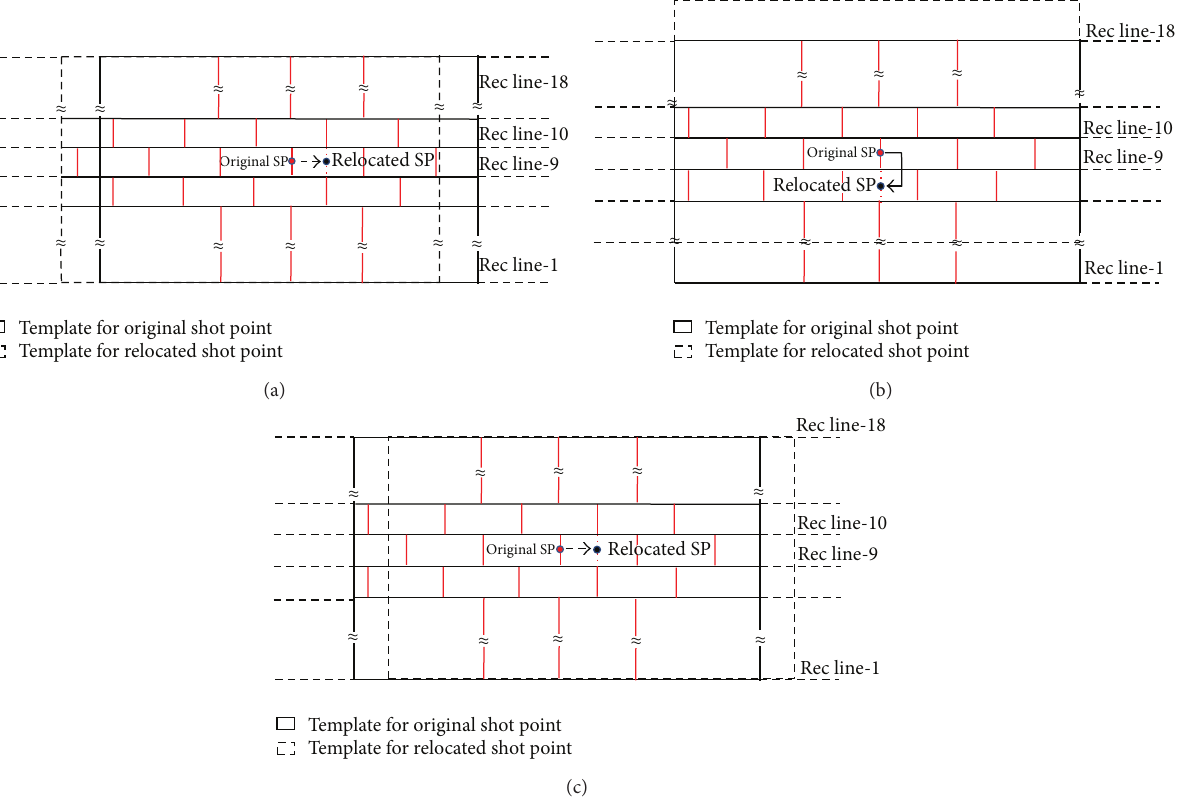
Figure 4: Offset-recovery methods. (a) Shot recovered at offset perpendicular to the shot-line with template moving in opposite direction. (b) Shot recovered at offset along the shot-line with template moving in opposite direction. (c) Relocation of the shots in the same swath with new template.